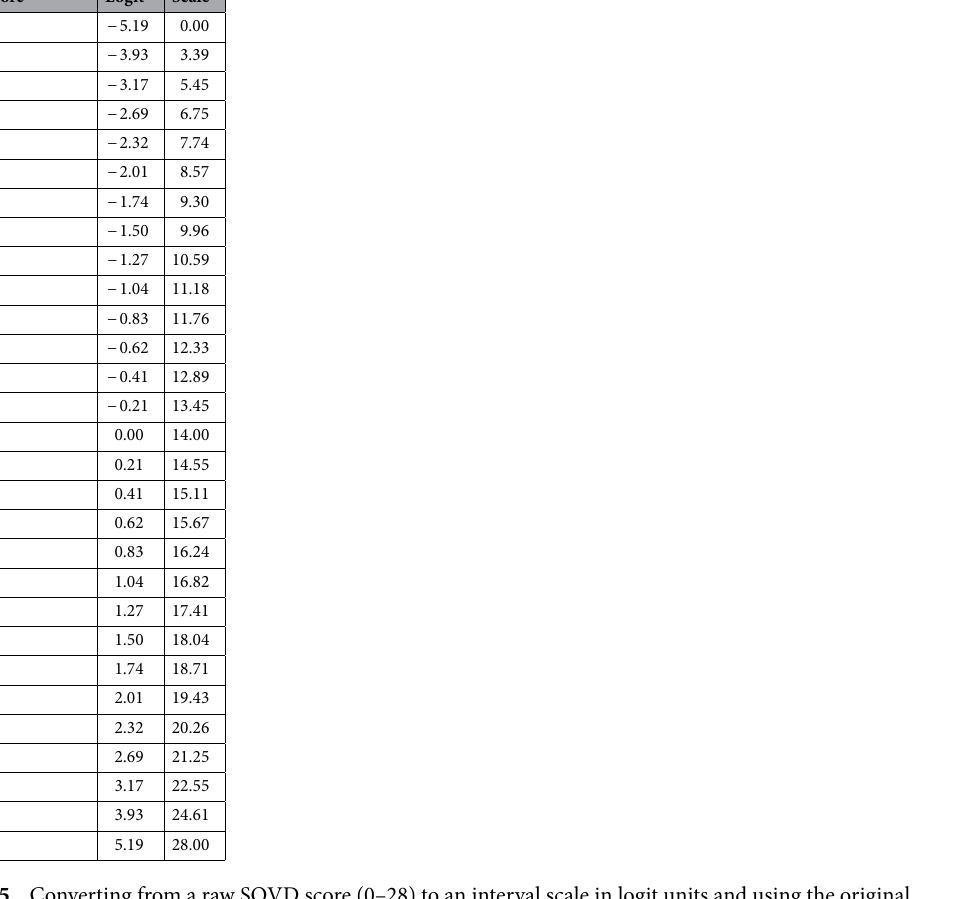
Table 5. Converting from a raw SQVD score (0–28) to an interval scale in logit units and using the original scale